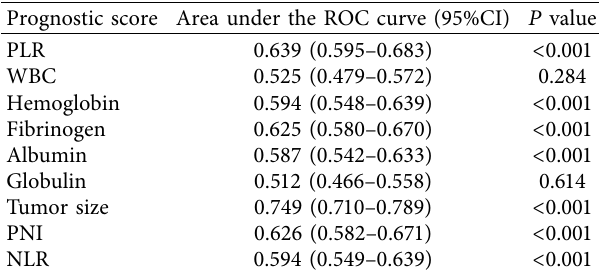
Table 1: The optimal thresholds for prognostic factor by the ROC